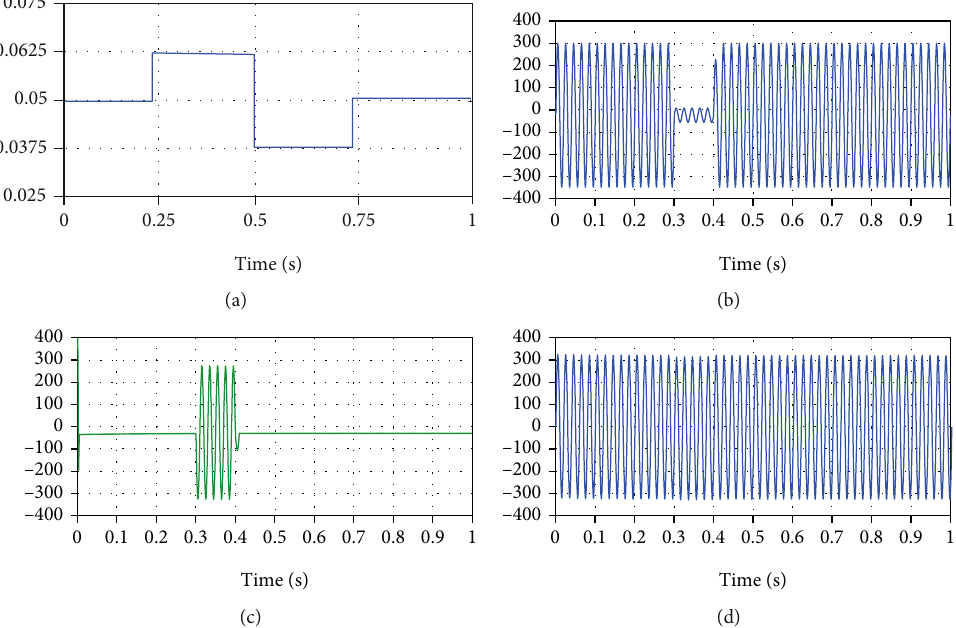
Figure 12: (a) Grid resistor changes. (b) A sag in the grid voltage estimated ̂ x of the sensitive load after compensation.